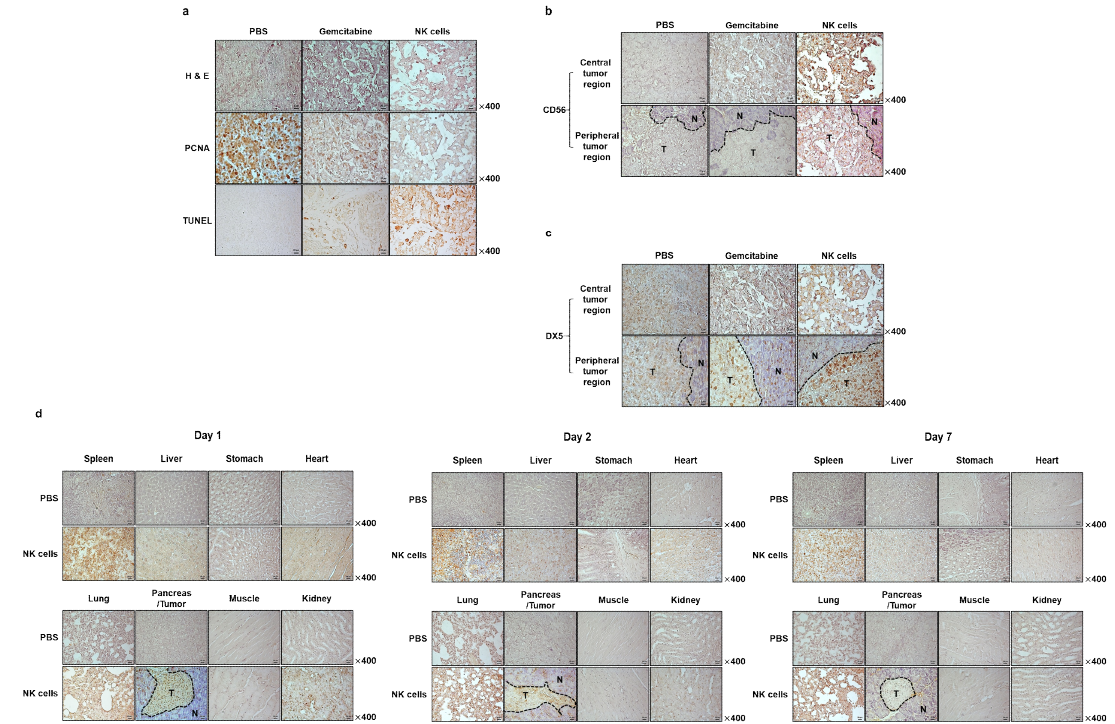
Figure 8. Histological and immunohistochemical analyses of tumor tissues from mice treated with natural killer (NK) cells. Tumor tissues were collected from mice at 3 days after the final treatment. ( a ) Representative sections were stained with hematoxylin and eosin (H & E), and the expression of proliferating cell nuclear antigen (PCNA) was assessed by immunohistochemistry. Terminal deoxynucleotidyl transferase dUTP nick end labeling (TUNEL) assays were performed to assess induction of apoptosis in tumor tissues. Tumor tissues were stained with ( b ) anti-CD56 or ( c ) anti-DX5 antibody to assess intratumoral infiltration of NK cells. Original magnification, × 400. Images are representatives of results from three independent experiments. ( d ) NK cells were systemically administered 3 times a week for 2 weeks to MIA PaCa-2 orthotopic tumor-bearing mice. Spleen, liver, stomach, heart, lung, pancreas, tumor, muscle, and kidney tissues were harvested at 1, 2, or 7 days post-final injection to evaluate the biodistribution profiles of NK cells. Immunohistochemistry was performed to analyze human NK cell accumulation in each tissue. Original magnification, × 400. Similar results were obtained from at least three separate experiments. T, tumor tissues; N, normal tissues.